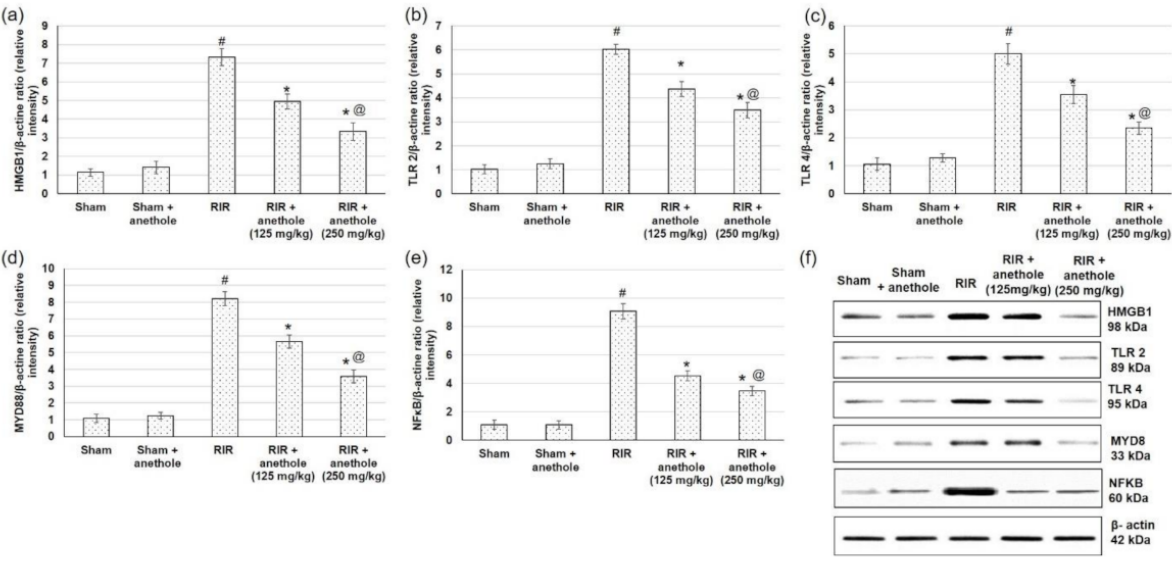
Figure 5. Effects of anethole (125 and 250 mg/kg) administration for 14 days prior to renal is- chemia/perfusion (RIR) on the renal protein expression of ( a ) HMGB1, ( b ) TLR2, ( c ) TLR4, ( d ) MYD88, ( e ) NF κ B and ( f ) protein expression of HMGB1,TLR2,4, MYD88 and NF κ B in RIR-induced injury. All values are stated as mean ± SD. # designates statistically significant compared to sham group, * designates statistically significant compared to RIR group, and @ designates statistically significant compared to RIR + anethole 125 mg/kg group ( p < 0.05) using one-way ANOVA followed by Tukey’s post hoc